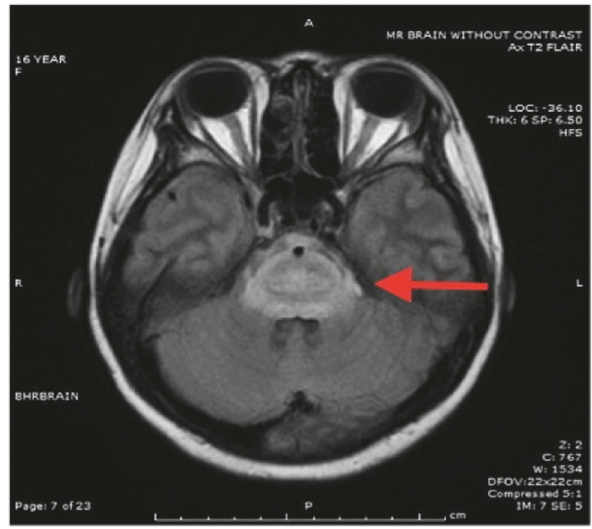
Figure 1: T2-FLAIR Axial image showing diffuse pontine edema.